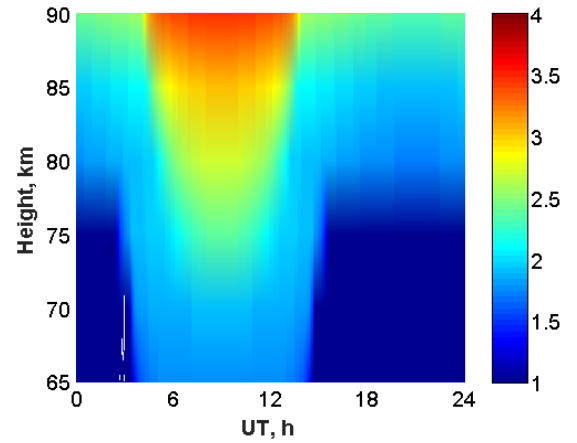
Fig. 5. The average electron density of model data (lg[ N e ], cm 3 ) on March 13, 14, 16-20, 24-26, 2017. In the Fig.5 diurnal variations of electron density profiles are shown in the altitudinal range from 65 to 90 km according to model calculations and observations in Fig.6.